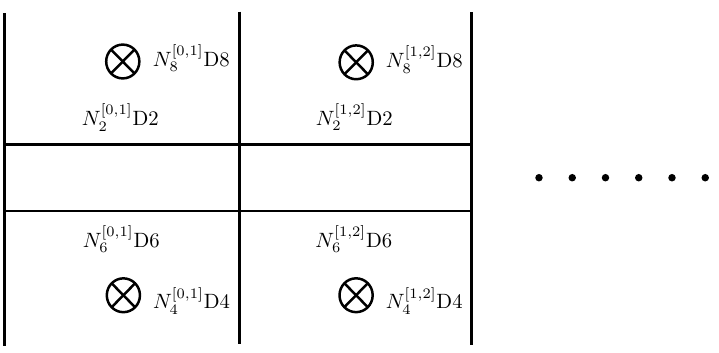
Figure 1 . The generic Hanany-Witten set-up associated with our backgrounds. The vertical lines are NS-(cid:12)ve branes. The horizontal lines represent D2 and D6 branes. The crosses indicate D4 and D8